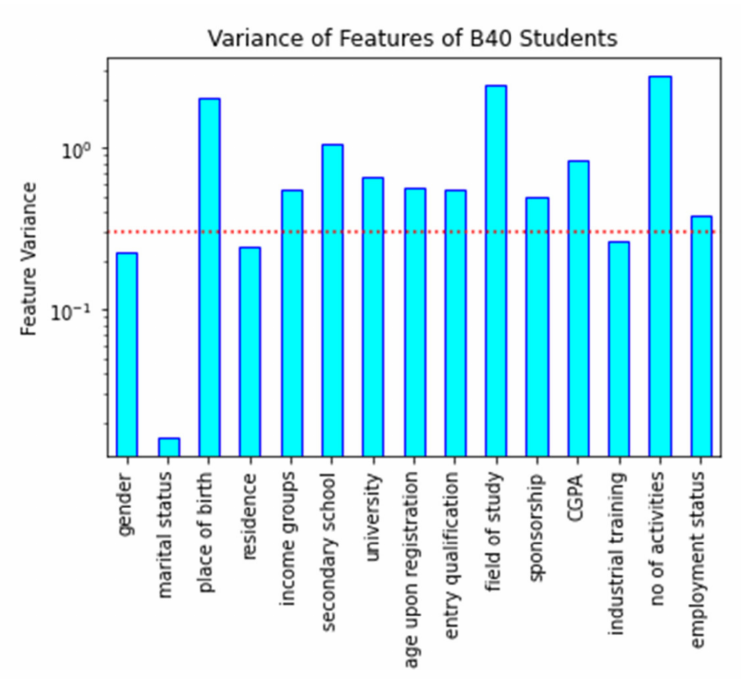
Figure 2. Variances of the features.